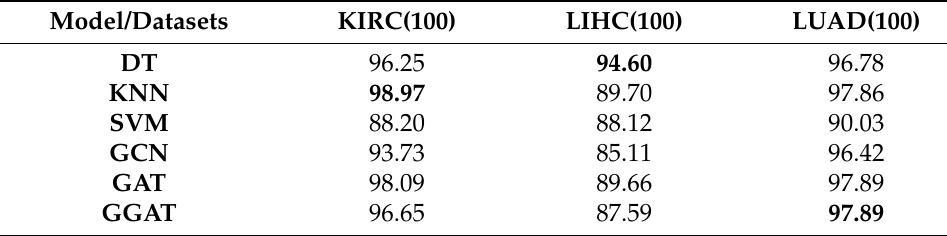
Table 10. Accuracy (%) of Models Under 100 Feature Dimensions.